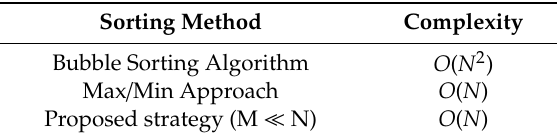
Table 1. Complexity Evaluation.